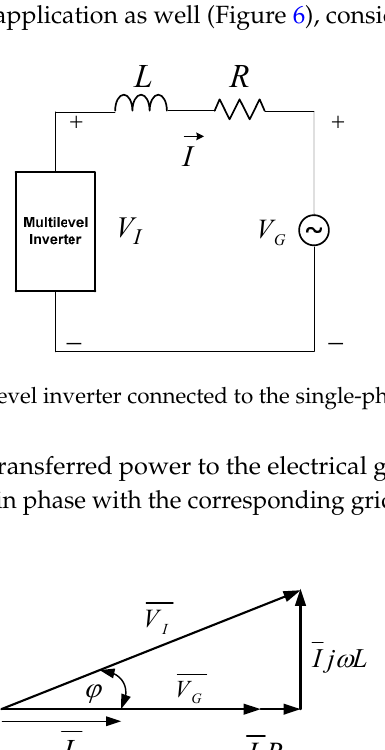
Figure 7. Phasor diagram for maximum transferred power.